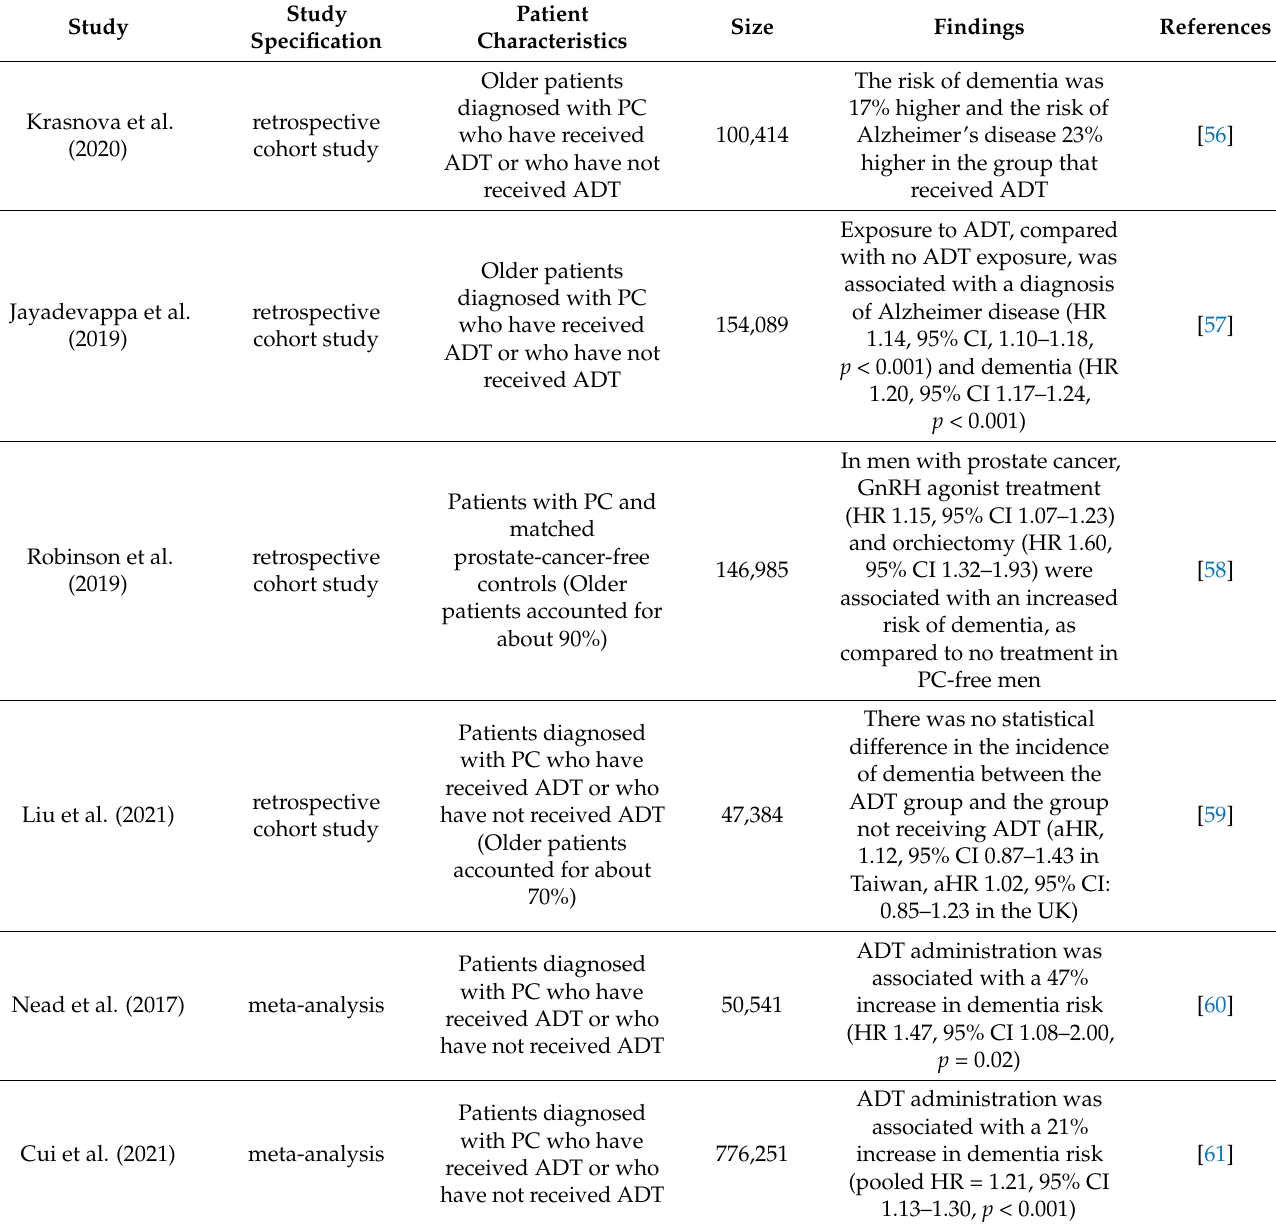
Table 4. Risk of ADT-induced dementia in older